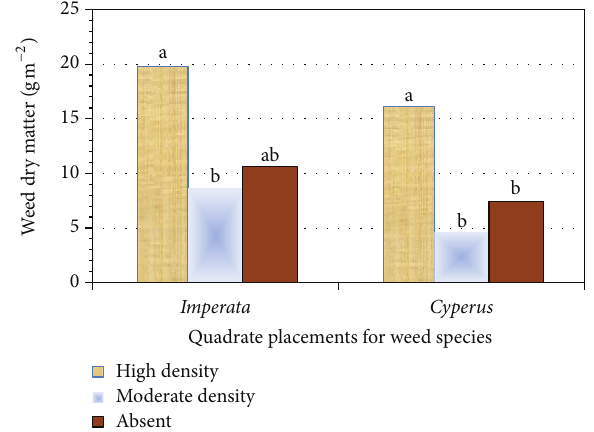
Figure 2: Weed biomass dry matter in quadrate placements for different densities of Imperata and Cyperus (a and b are indicating mean values that are different